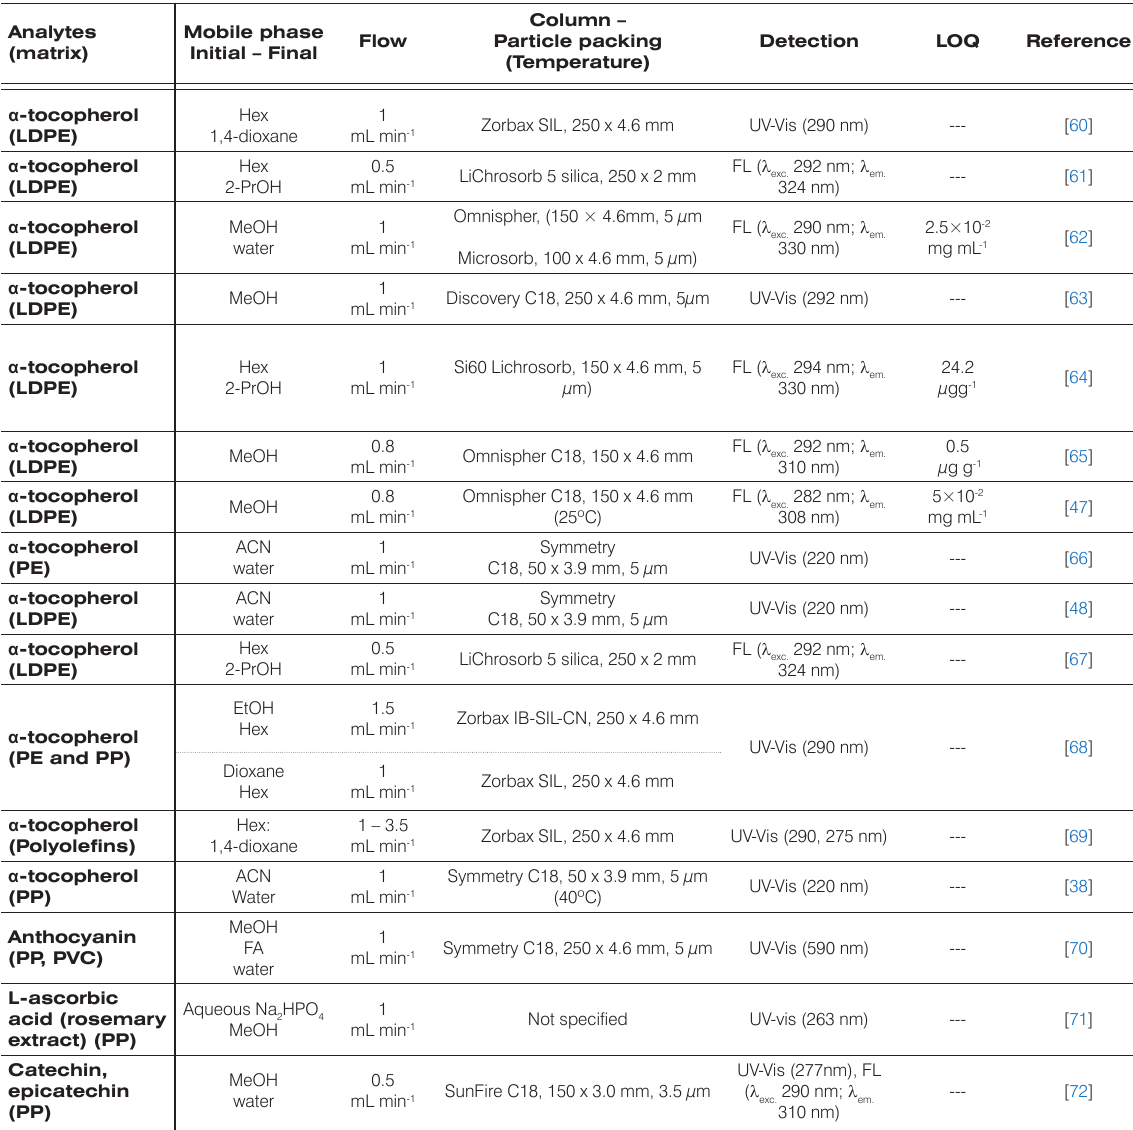
Table 2. Summary of liquid chromatography based methods for the determination of natural antioxidants in plastics. Analytes